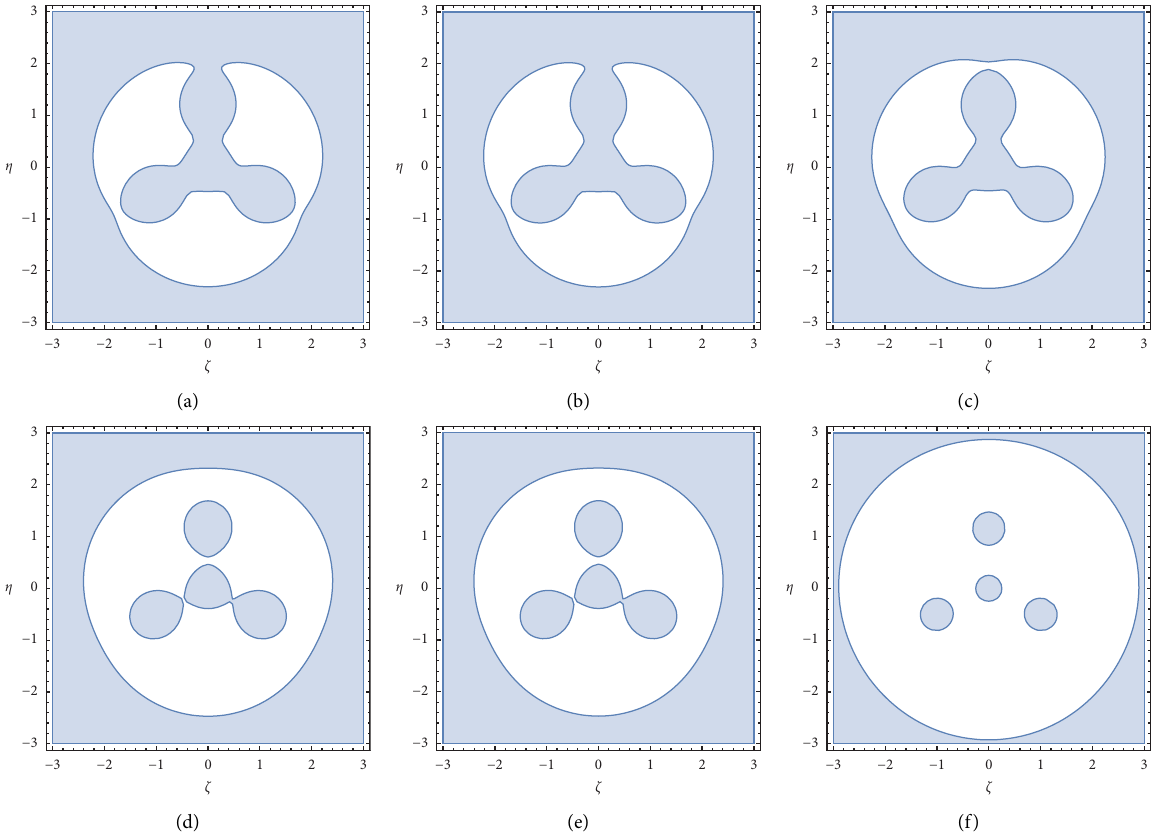
Figure 6: Case I: regions of motion for m (e) C � − 4 . 51, (f) C � − 5 .